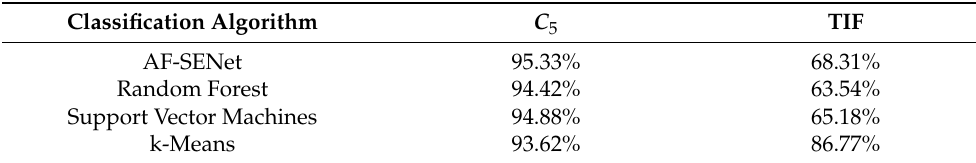
Table 7. Comparison of the classification accuracy of this article’s optimal deep feature fusion combination (ResNet50 v2-DenseNet121) and the machine learning methods of different features (four